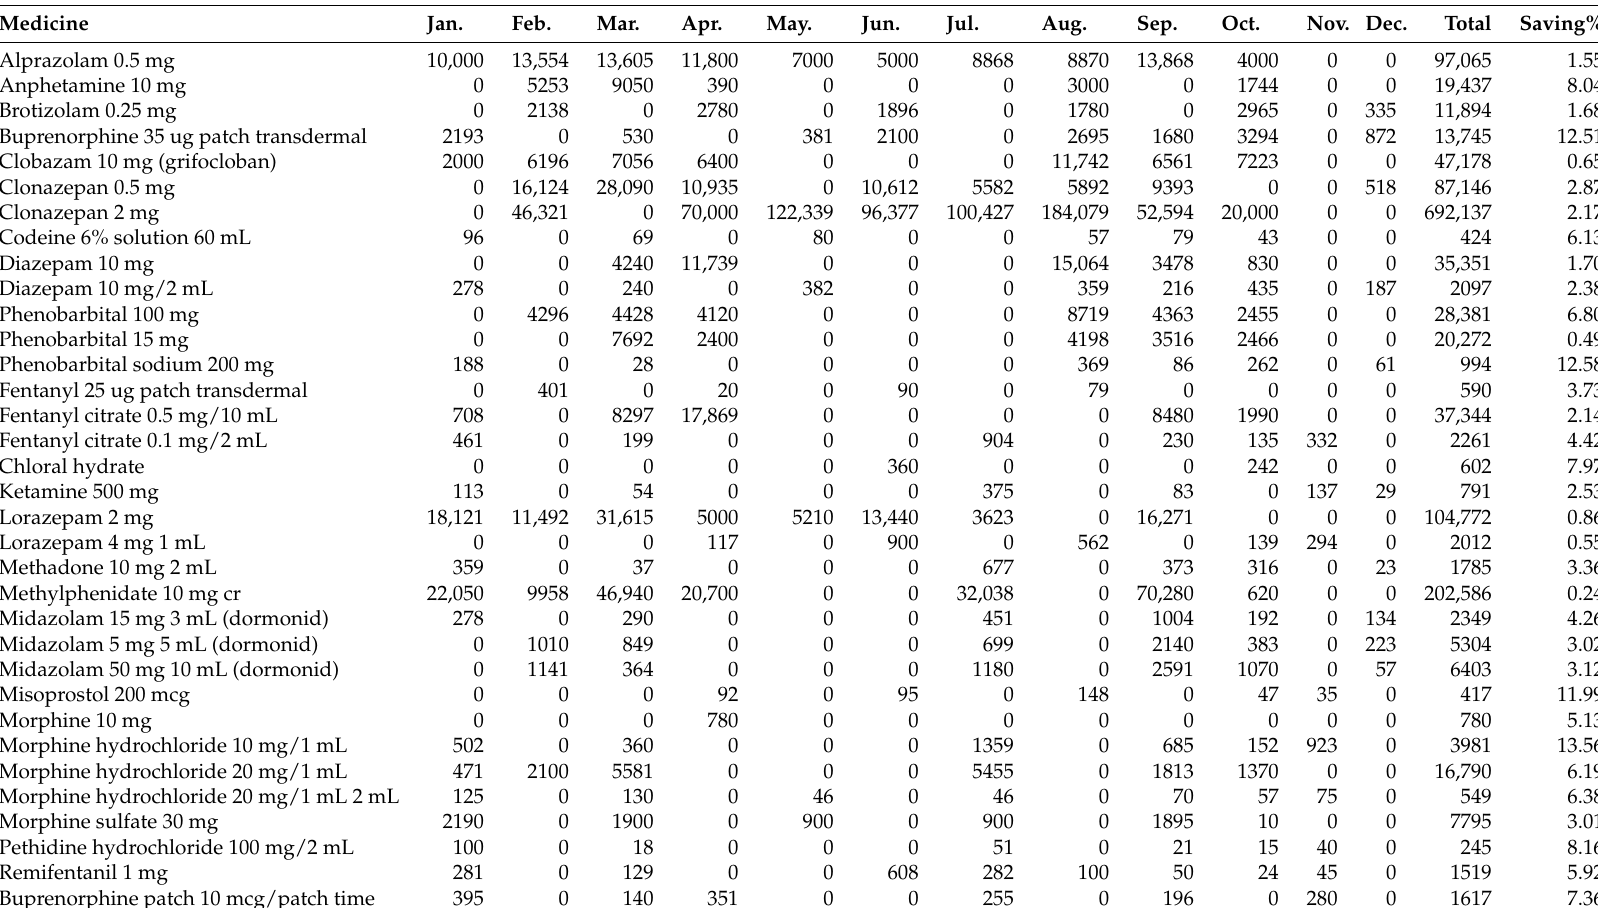
Table A2. Monthly purchase volume (in units) induced by DM for the 34 medication of the controlled medication pharmacy of the HRT during 2018. Medicine Alprazolam 0.5